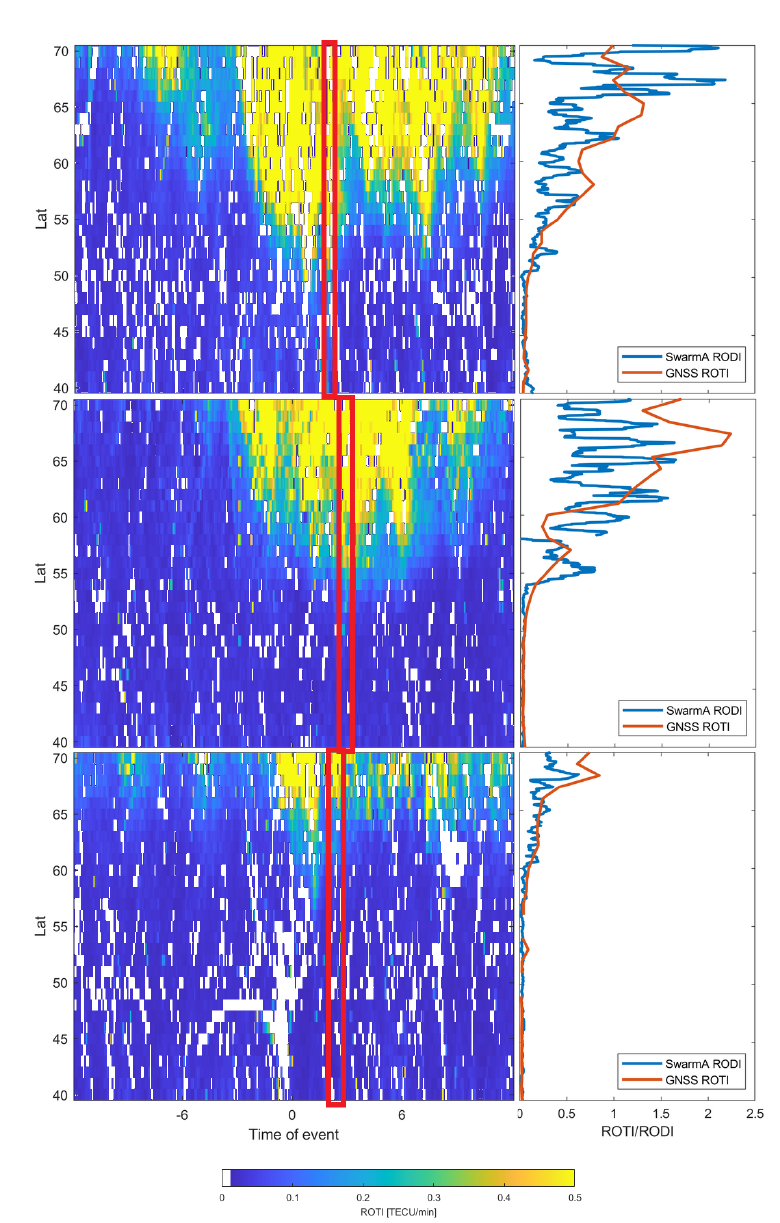
Figure 5. Selected examples of GNSS ROTI validation with RODI data derived from Swarm in situ plasma density measurements. Cases of 17 March 2015, 6 March 2016 and 11 September 2015,